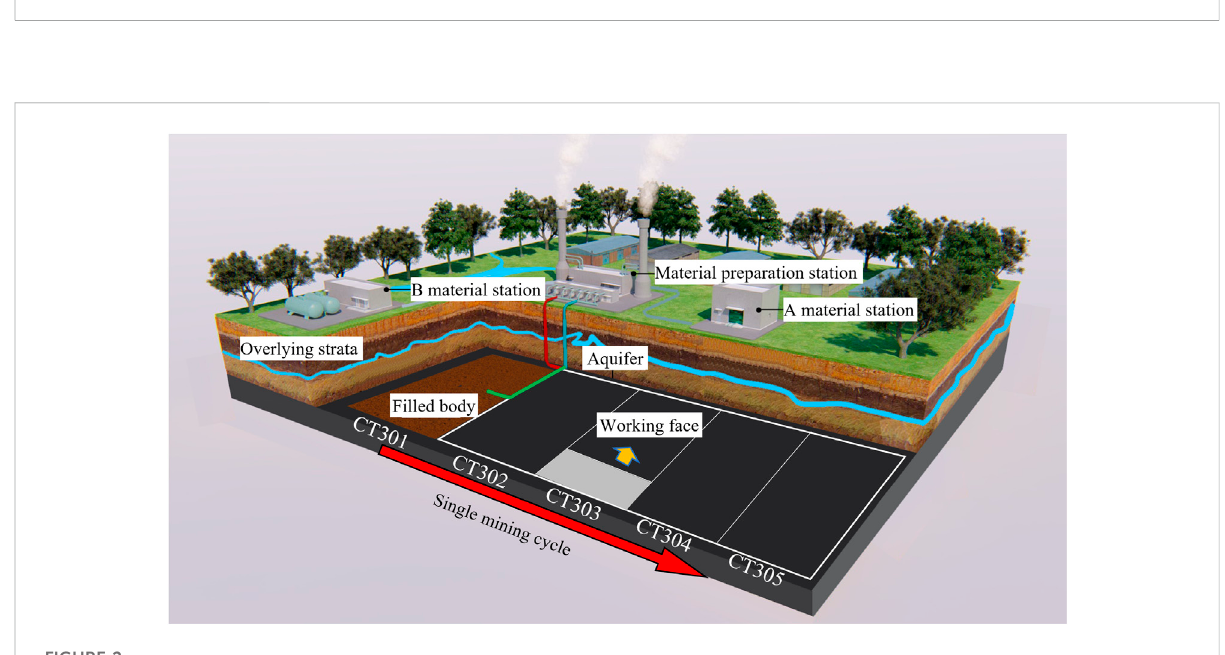
FIGURE 2 The principle diagram of SCFM